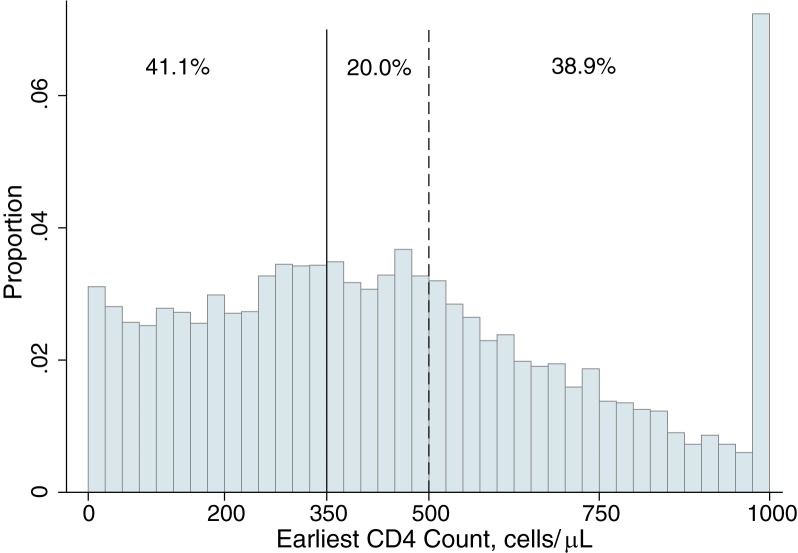
Distribution of earliest CD4 counts among patients seeking care for HIV in 2013.Data include all patients presenting to the Hlabisa HIV Treatment and Care Programme, the public sector ART program serving Hlabisa sub-district, rural KwaZulu-Natal. Data are shown for 2013, the last complete year for which data were available, and are top-coded at 999 cells. Under the assumption that the 2013 distribution of first CD4 counts reflects the future distribution among patients seeking care, the area under the curve between 350 and 500 shows the proportion of patients who would be expected to be newly eligible based on the January 2015 guideline revision. The proportion to the right of 500 shows the additional proportion of patients who would be expected to be eligible if South Africa adopts September 2015 WHO recommendations to initiate all patients regardless of CD4 count.